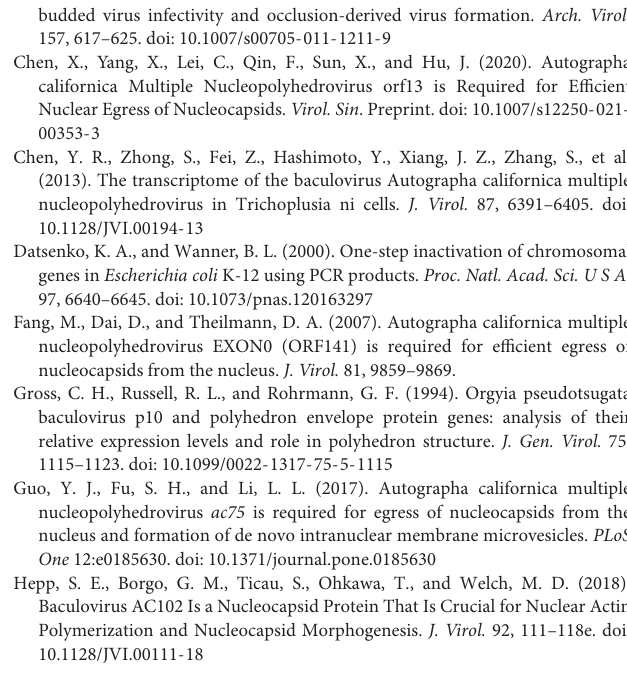
Supplementary Figure 3 | Immunofluorescence analysis of localization and expression of AC75 in vAc- ph -infected cells. Sf9 cells were infected with vAc- ph (MOI = 5) and fixed at the indicated time points. The cells were incubated with an anti-AC75 antibody (red). The nuclei were stained with Hoechst 33258